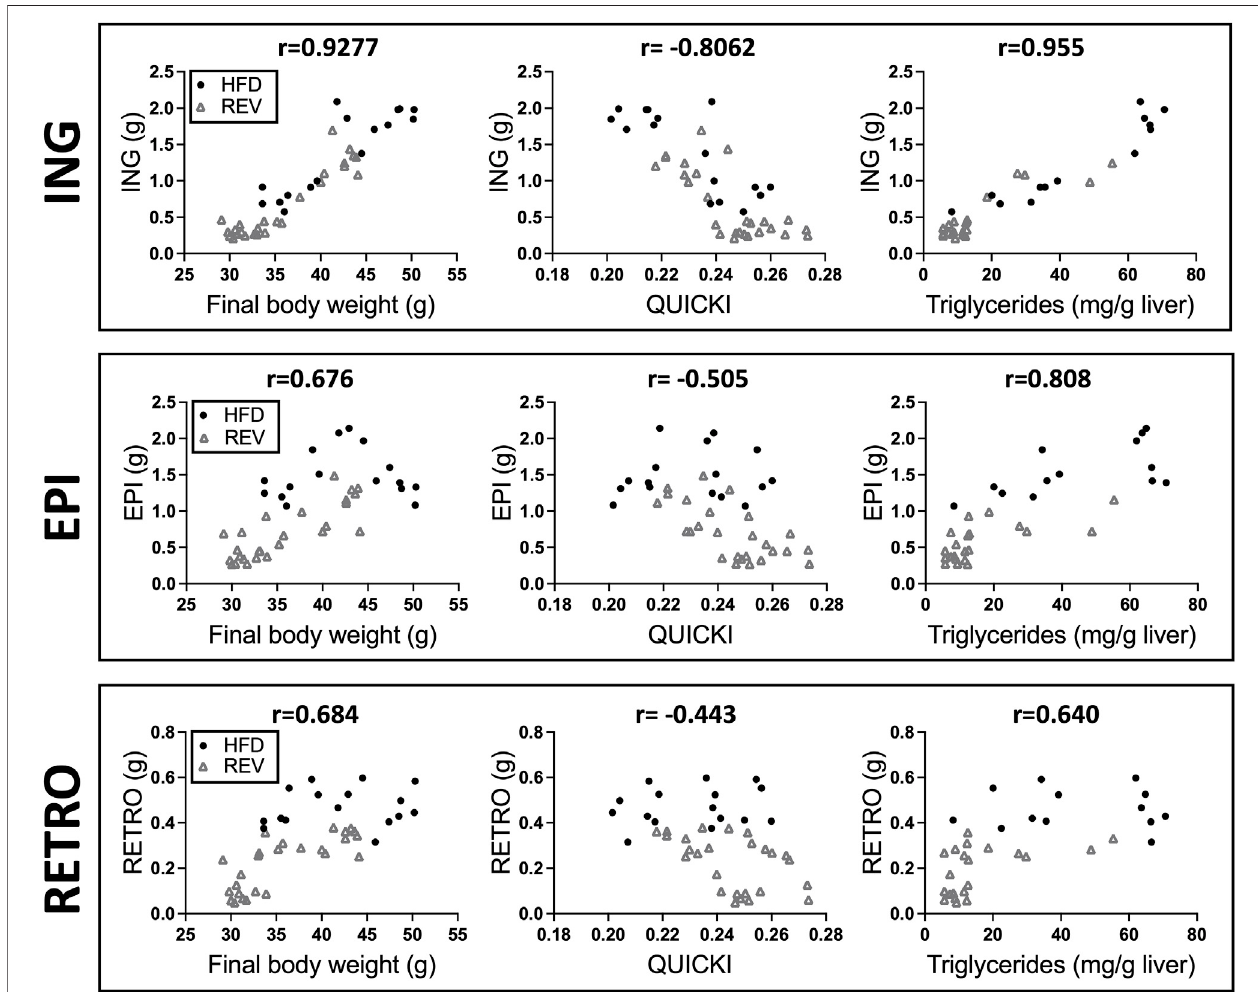
FIGURE 3 | Correlation analysis between different fat depots and body weight, QUICKI or liver triglycerides. Scatter plot displaying correlation between fat depot mass (g) and fi nal body weight, QUICKI or liver triglycerides, (ING, top panel), (EPI, middle panel), and (RETRO, bottom panel). Pearson correlation with corresponding r valueisdisplayedineachgraph.ThedataareobtainedfromHFD(blackdot)andREV(graysquare)groupsfrom4,8and12wofintervention(seestudyoutline Figure1 ).